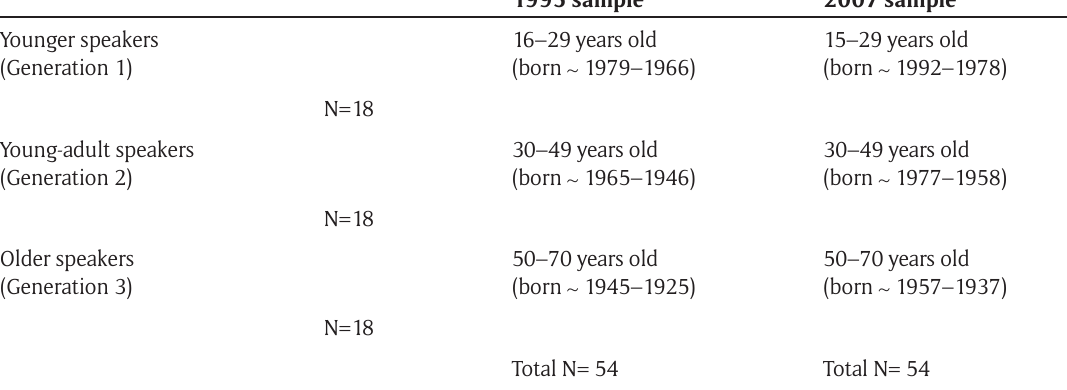
Table 1: Age distribution in each of three age groups for each speech sample. Note : The 1995 sample corresponds to Carvalho’s